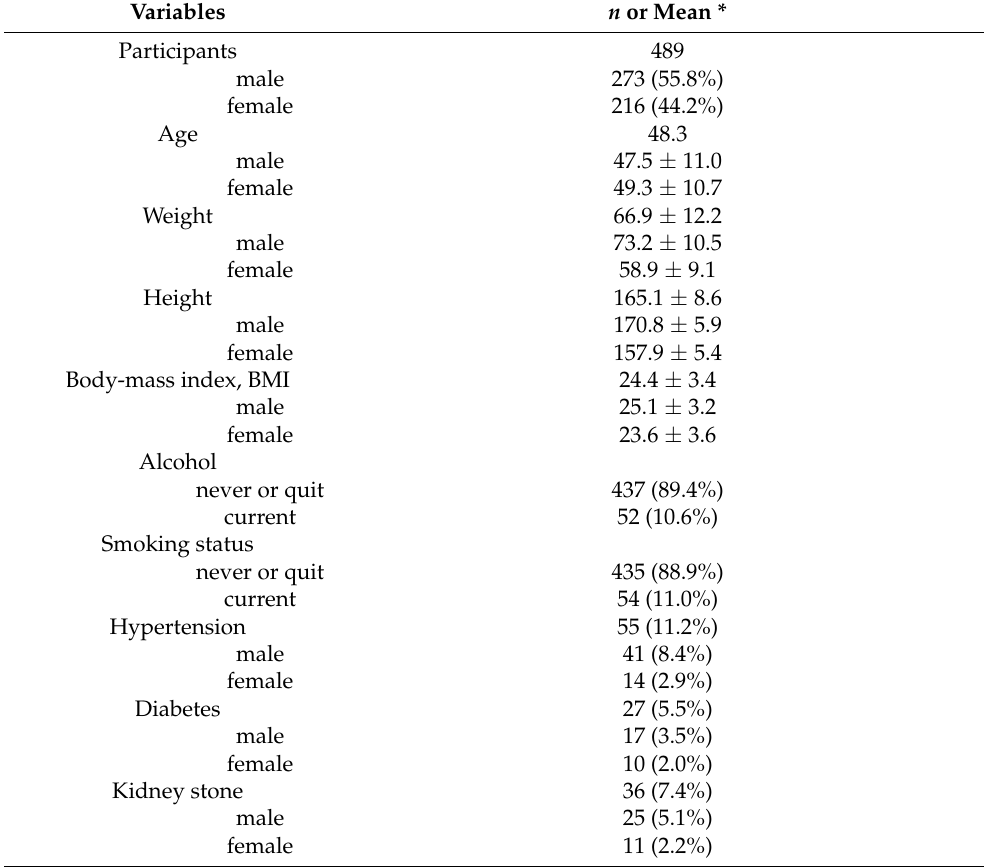
Table 1. Demographic and clinical characteristics of